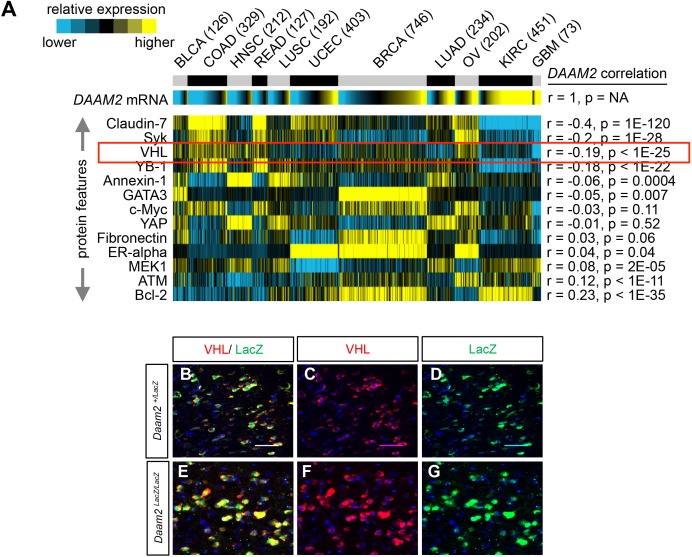
Correlation between Daam2 and proteins suppressed in glioma.Correlation of Daam2 mRNA expression with the core set of proteins downregulated in the PB-Ras Daam2-GOF RPPA analysis. Please also see Figure 4a and Figure 4—figure supplement 1, panel E. Across a broad spectrum of cancers. Protein and mRNA expression data across this broad spectrum of cancer was derived from samples obtained from The Cancer Proteome Atlas (TCPA) and correlations with Daam2 mRNA was performed using Pearson’s. Abbreviated cancer type is listed on top panel and number of tumors analyzed in the TCPA dataset for each cancer type is listed in parenthesis. VHL is highlighted in red box. (B–G) Immunostaining showing Daam2-LacZ and VHL expression in the adult cortex from Daam2LacZ/+ and Daam2LacZ/LacZ mice. Note that the levels of VHL that are co-expressed with Daam2-LacZ are increased in the Daam2LacZ/LacZ mice compared to Daam2LacZ/+ mice (C v. (F).